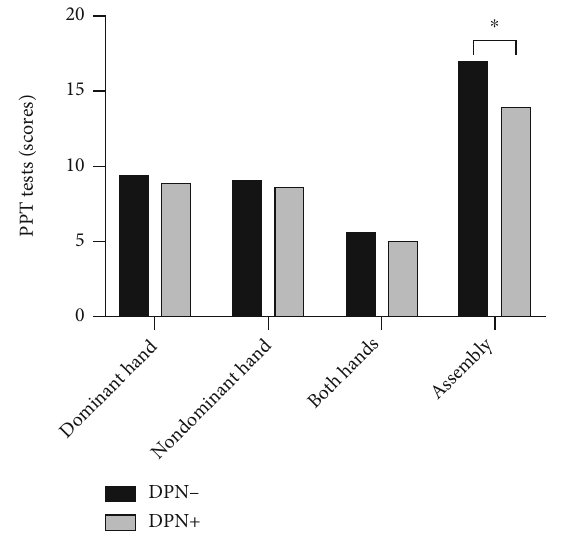
Figure 5: Di ff erences between the two Purdue Pegboard Tests (PPT). ∗ A p value < 0.05 was considered to indicate statistical signi fi